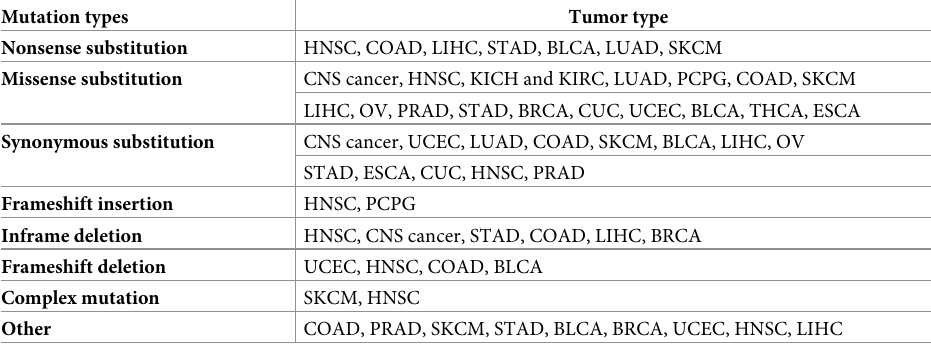
Table 2. CALR mutation types in tumors (COSMIC).